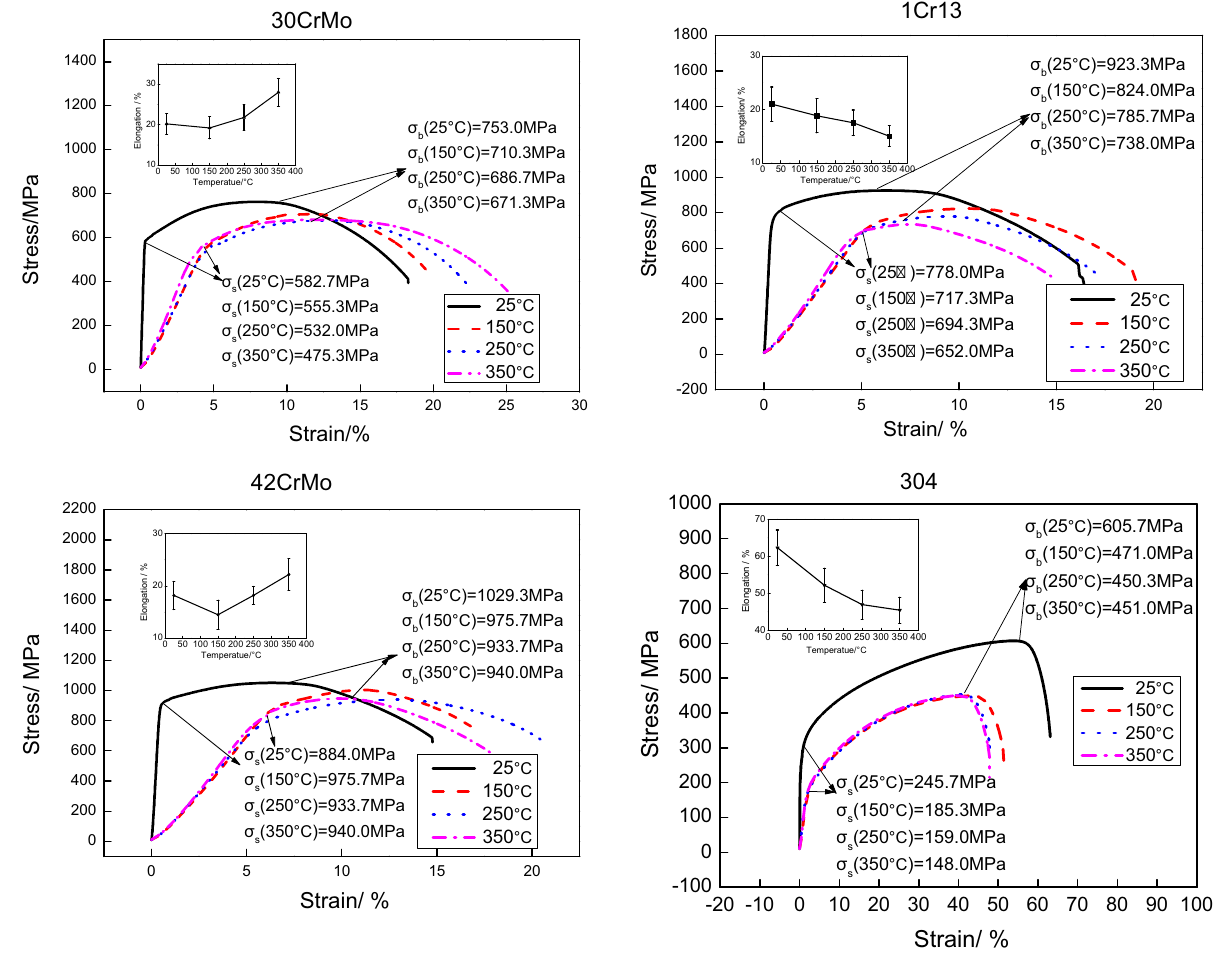
Figure 1: Stress – strain curves of 30CrMo, 42CrMo, 1Cr13, and 304 steel at 25, 150, 250, and 350°C ( including the summary of yield strength - σ - σ ) s , tensile strength b , and elongation